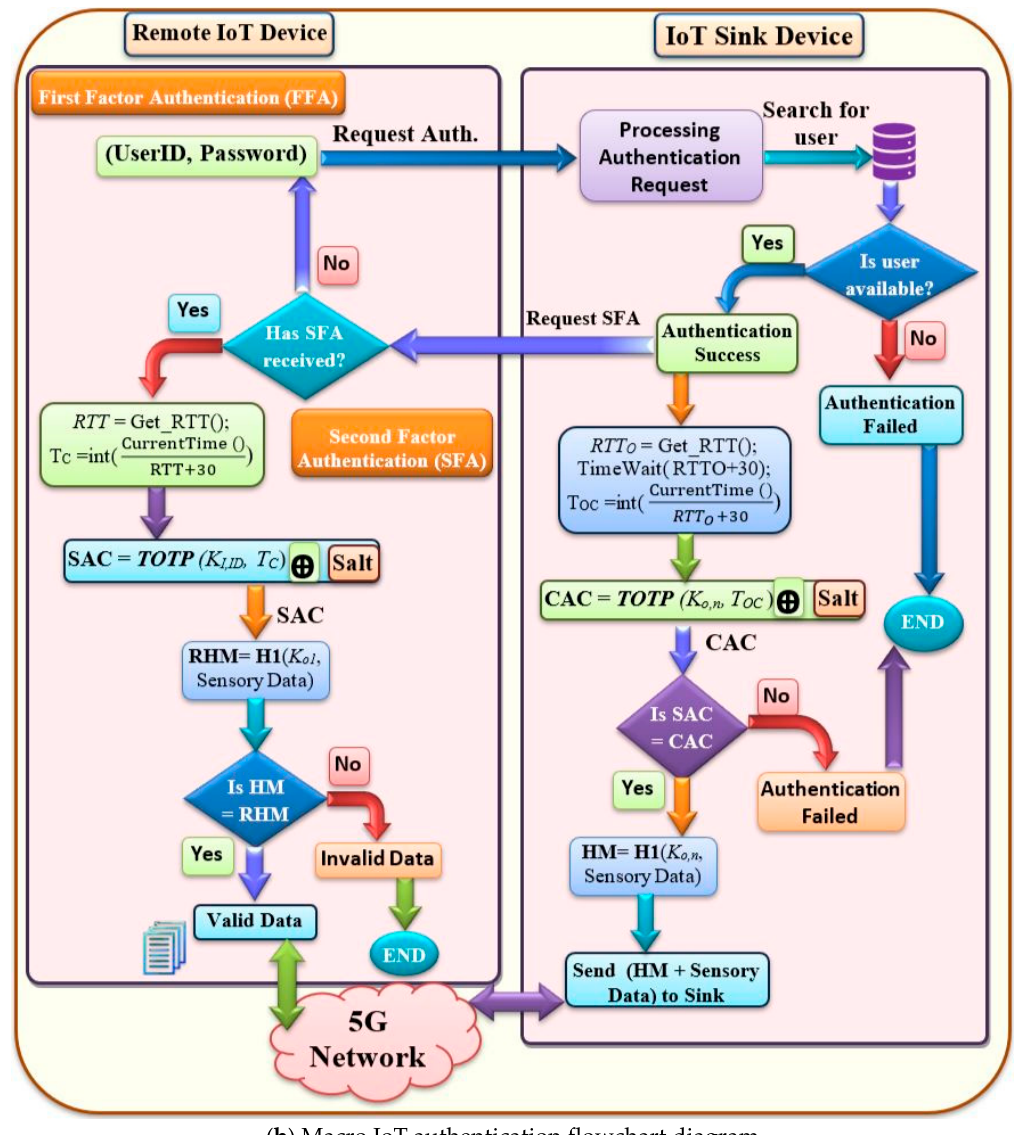
Figure 3. System design of Macro IoT authentication.